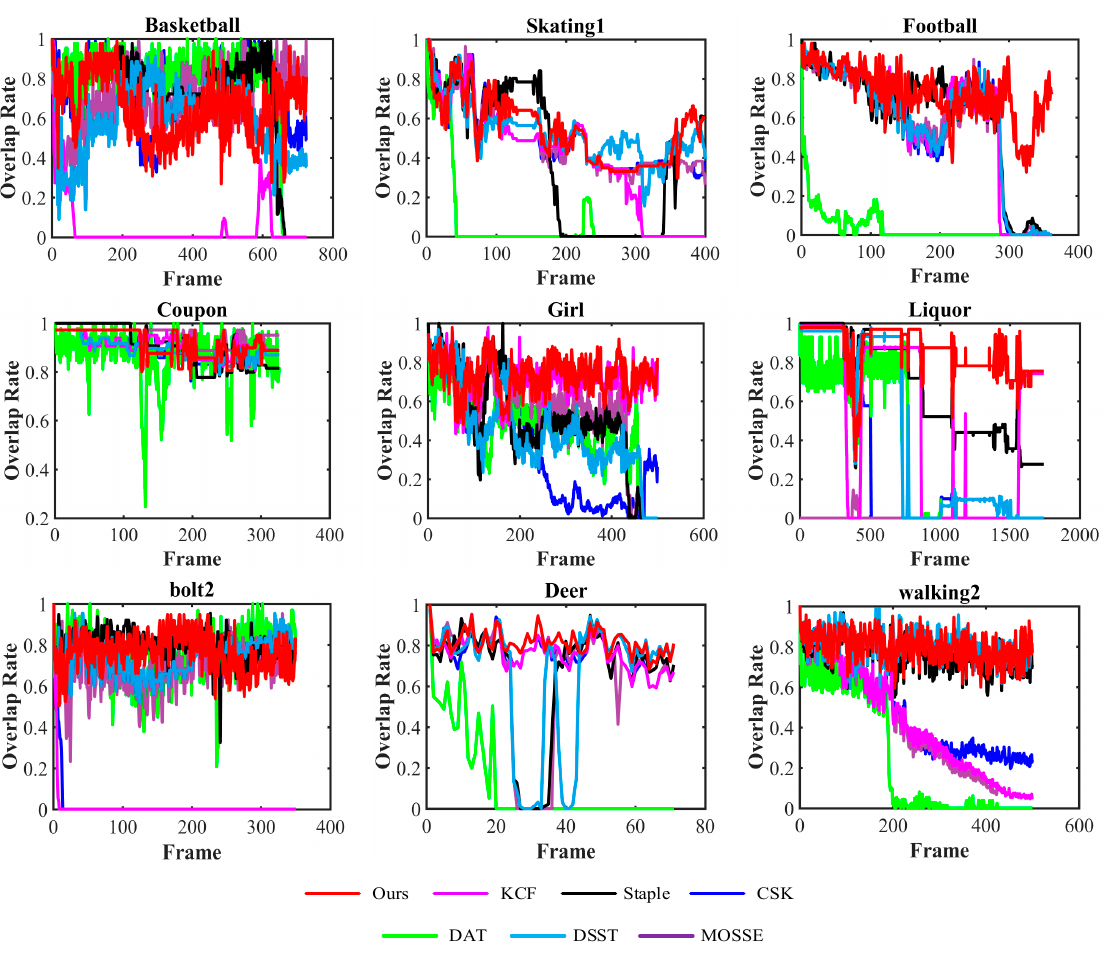
Figure 4. Frame-by-frame comparison of seven trackers on nine video sequences in terms of overlap ratio. The horizontal axis represents the frame number, and the vertical axis represents the overlap rate. The greater is the value, the better is the tracking accuracy.